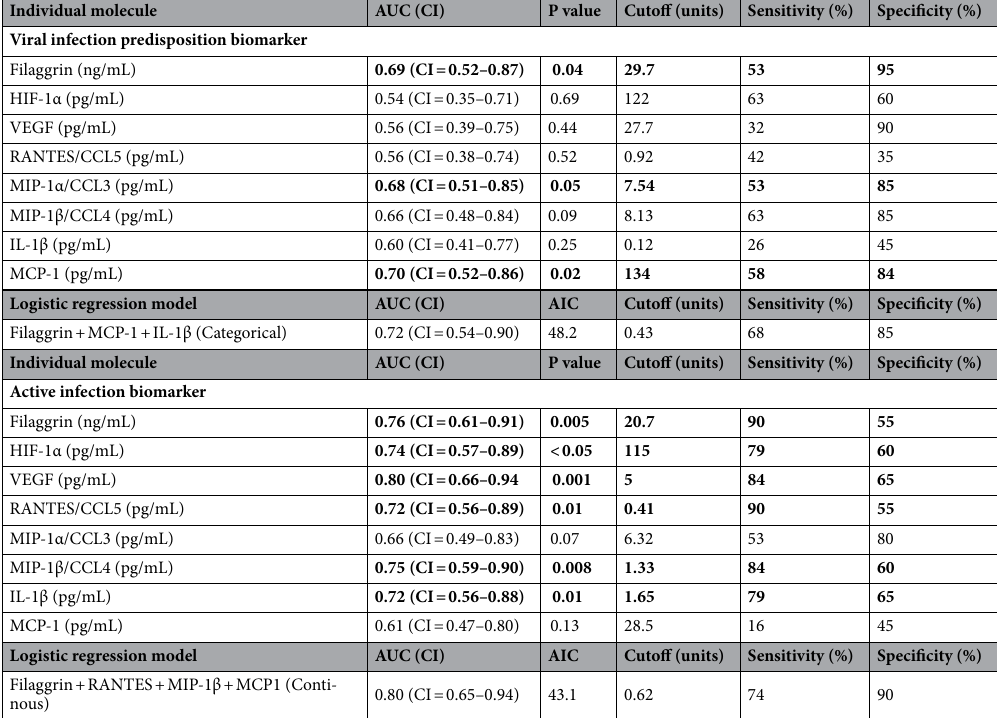
Table 2. Diagnostic value of supernatant molecules to differentiate between virus-negative premature controls against pre-infection premature infants and against those with ongoing infection. Significant values are in bold. AUC Area under the curve, AIC Akaike information criterion, CI confidence interval.